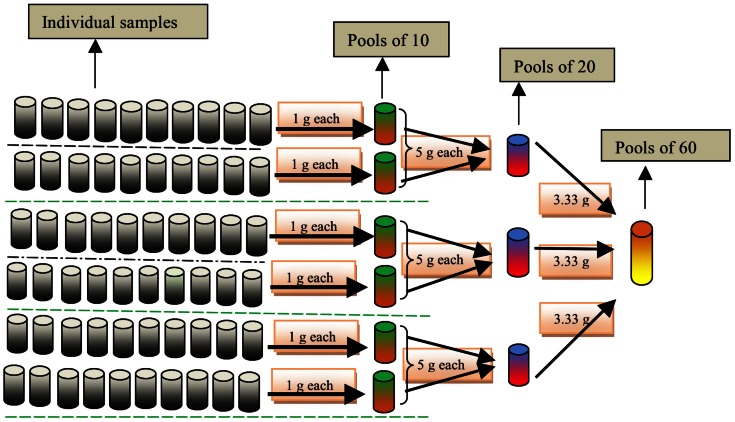
Procedure to obtain pools of 10, 20, and 60 individual stool samples.Sixty individual samples were arranged in 6 rows with each row consisting of 10 individual samples, subsequently 6 pools of 10, 3 pools of 20, and 1 pool of 60 individual samples, resulting in total of 10 pooled samples per school.